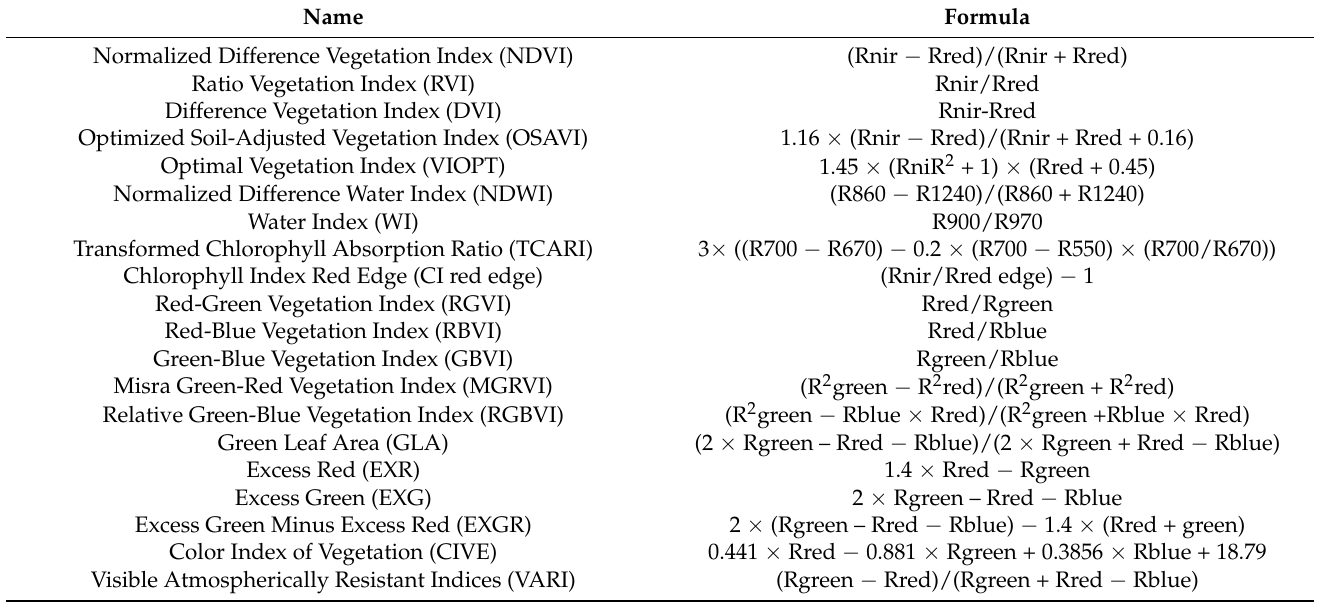
Table 1. Description of vegetation